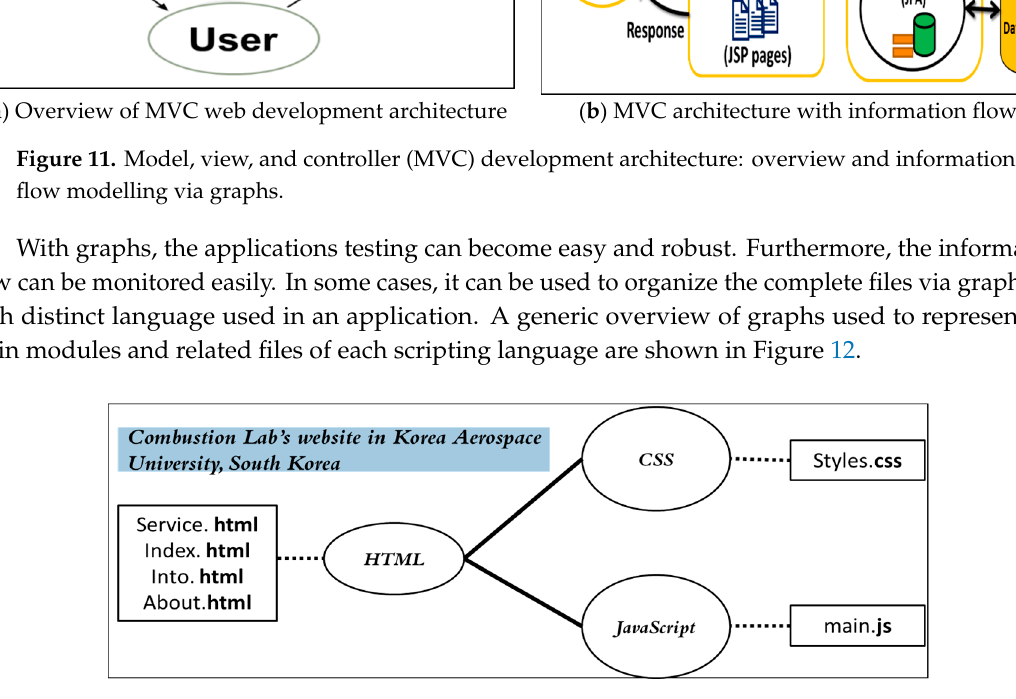
Figure 12. The use of graphs in organizing distinct category files used in a web application.